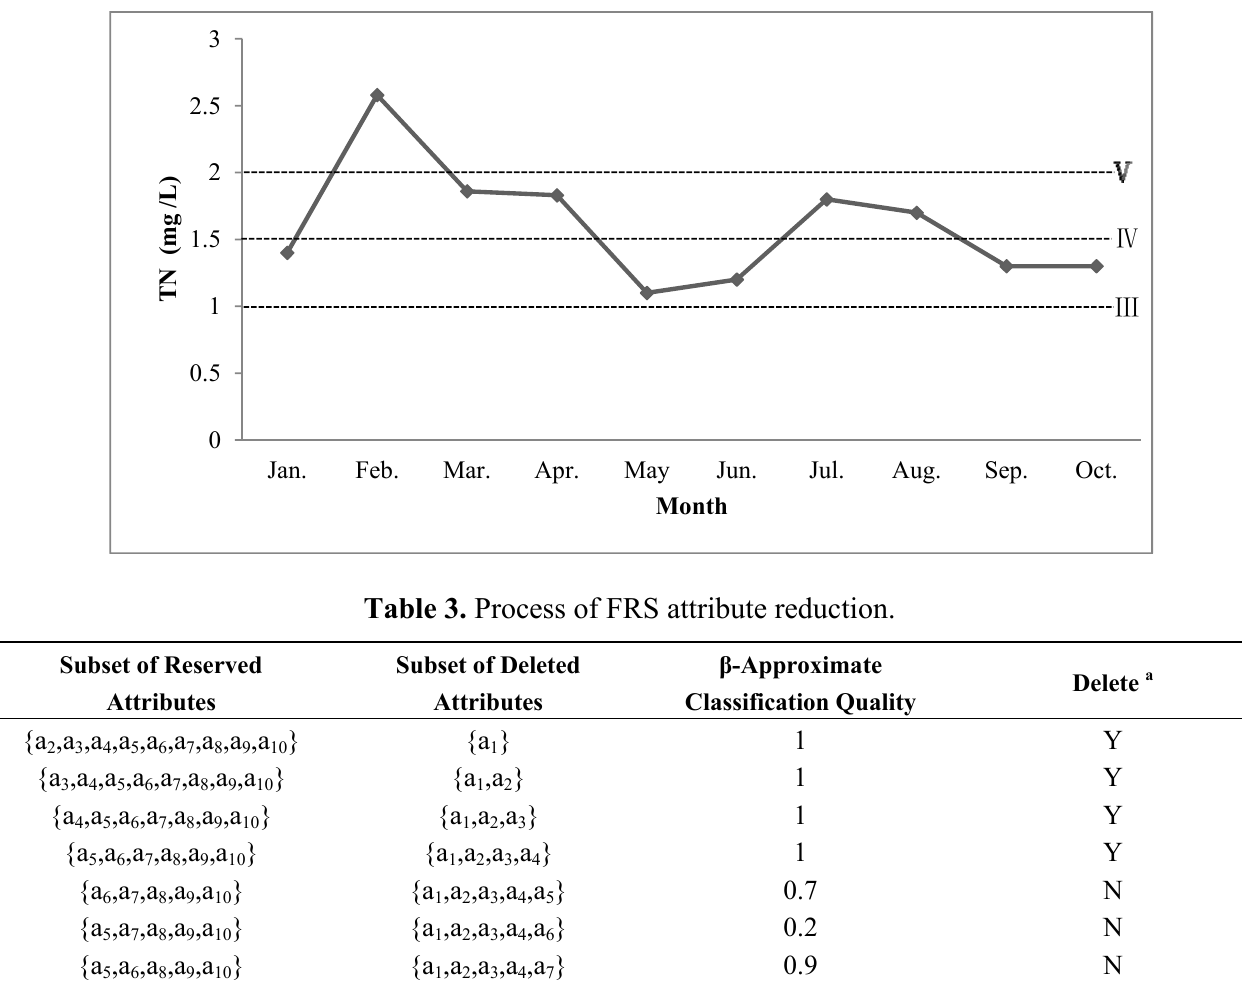
Figure 1. Plot of TN temporal distribution.